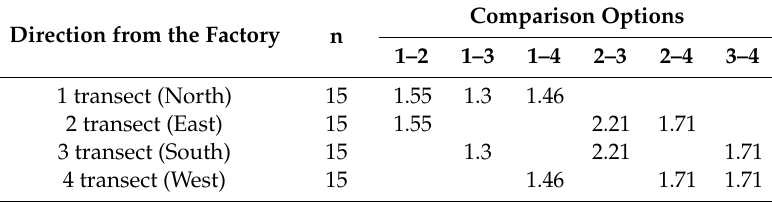
Table 11. Evaluation of di ff erences in the magnetic susceptibility of soils in transects in the